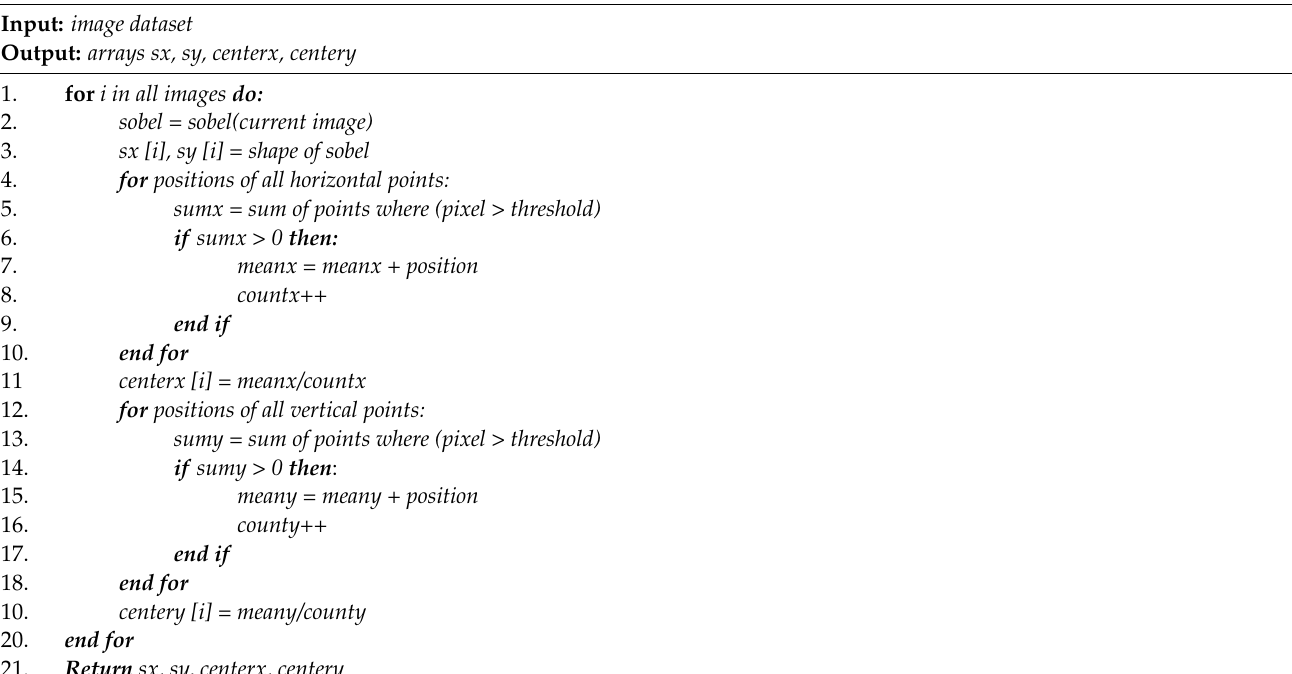
Algorithm 1: Extracting center points from sobel filter